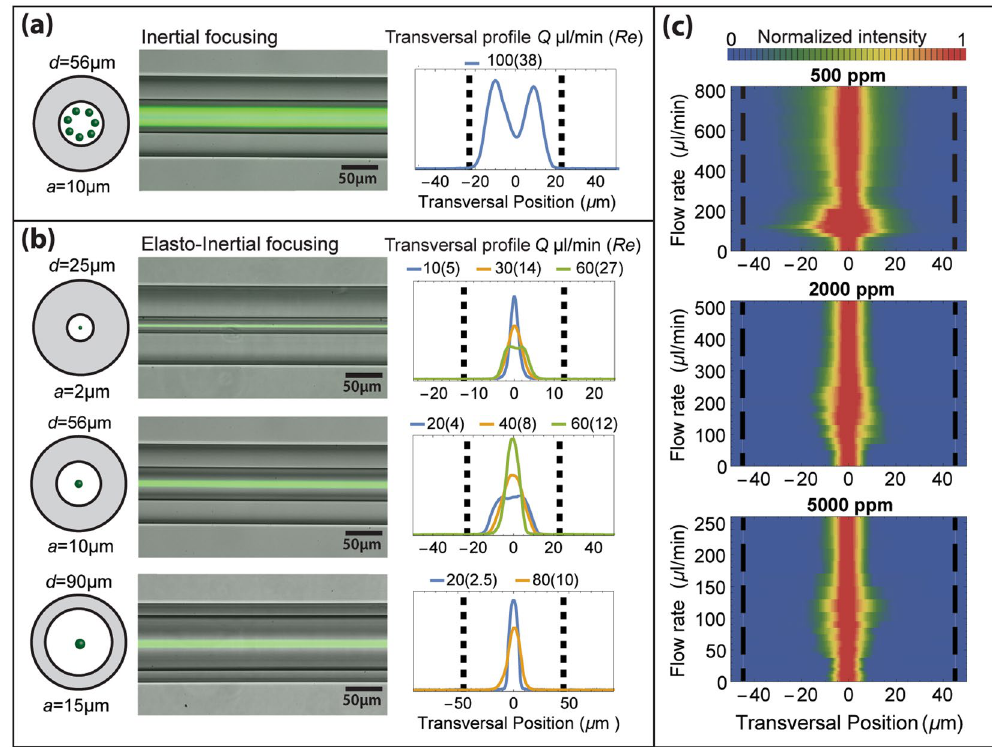
Figure 2. Particle focusing in capillary flow. ( a ) Inertial and ( b ) elasto-inertial focusing of particles of diameter a flowing in capillaries of diameter d . (left) schematic cross-section and long-exposure fluorescence microscopy image of focused particles, and (right) transversal profile obtained from fluorescence images indicating particle position for different flow rate ( Q ) and Reynold number ( Re ). Dashed black lines define the capillary walls; ( c ) Elasto-inertial focusing of 15- µ m particles flowing in a 90- µ m capillary at different flow rates for PEO concentrations of 500, 2000 and 5000 ppm. The figures consist of a contour plot made by stacking transversal profiles as a function of the flow